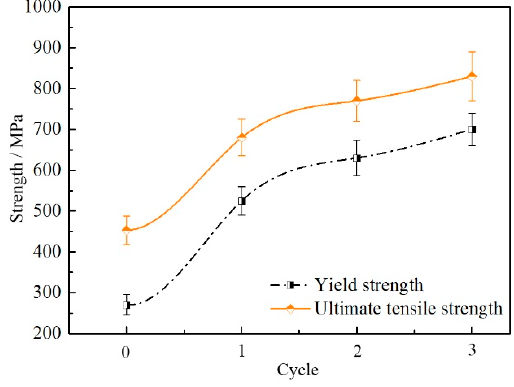
Figure 8. Tensile strength versus the MDF cycles.